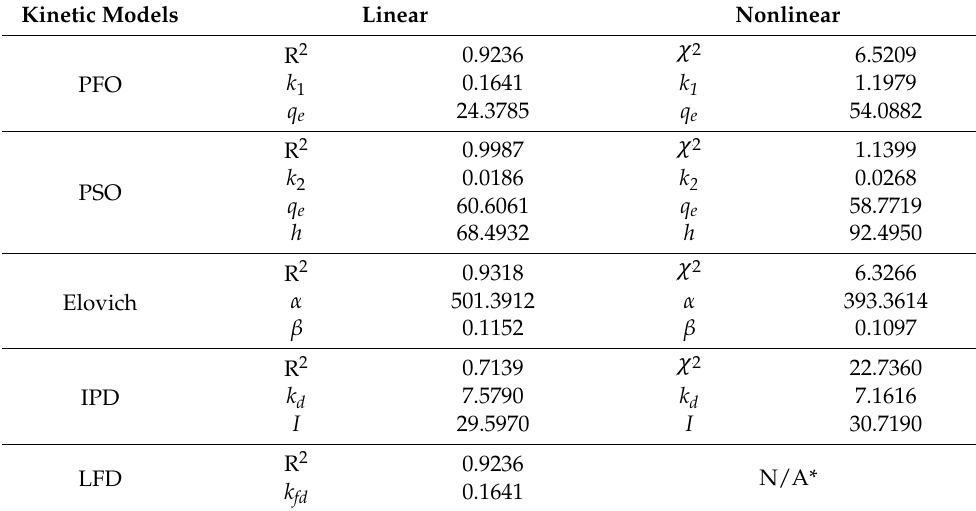
Table 2. Summary of linear and nonlinear equations of kinetic models and their